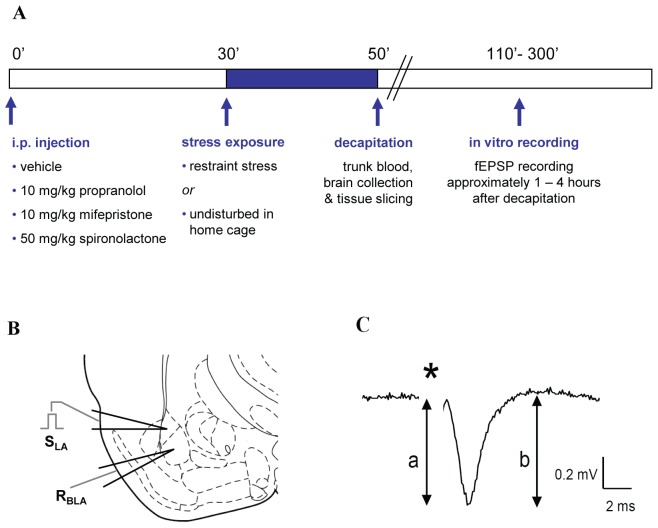
Schematic overview of the experimental design and method.
A Schematic time line of the experimental design. Thirty minutes after injection with vehicle or antagonist, mice were subjected to either restraint stress or left undisturbed. After another 20 min, animals were rapidly decapitated and brains were collected for slice preparation. Approximately 1–4 hours after decapitation, in vitro electrophysiological recordings were carried out. B Positioning of the stimulation (SLA) and the recording electrode (RBLA) at their sites within the lateral (LA) and the BLA respectively in mouse coronal brain slices. C) Representative local fEPSP evoked by stimulation of the LA–BLA pathway. The amplitude of the signal was calculated according to the formula (a+b)/2 as indicated in the figure. * indicates position of the stimulus artefact.